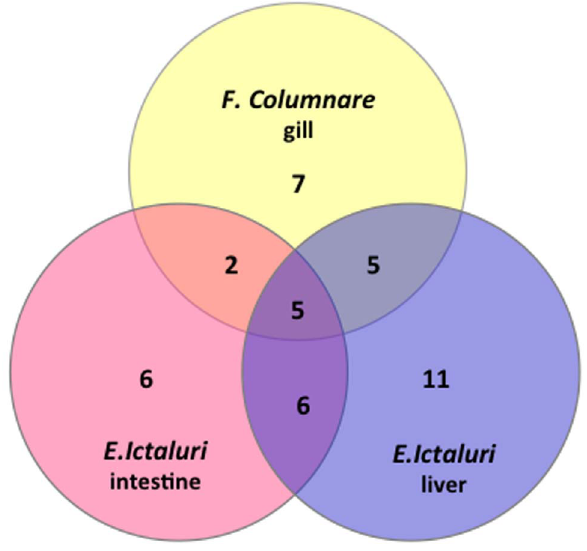
Fig. 8. Venn diagram of catfish Hsp40 gene expression showing overlapped pattern of induced expression under various challenge conditions.